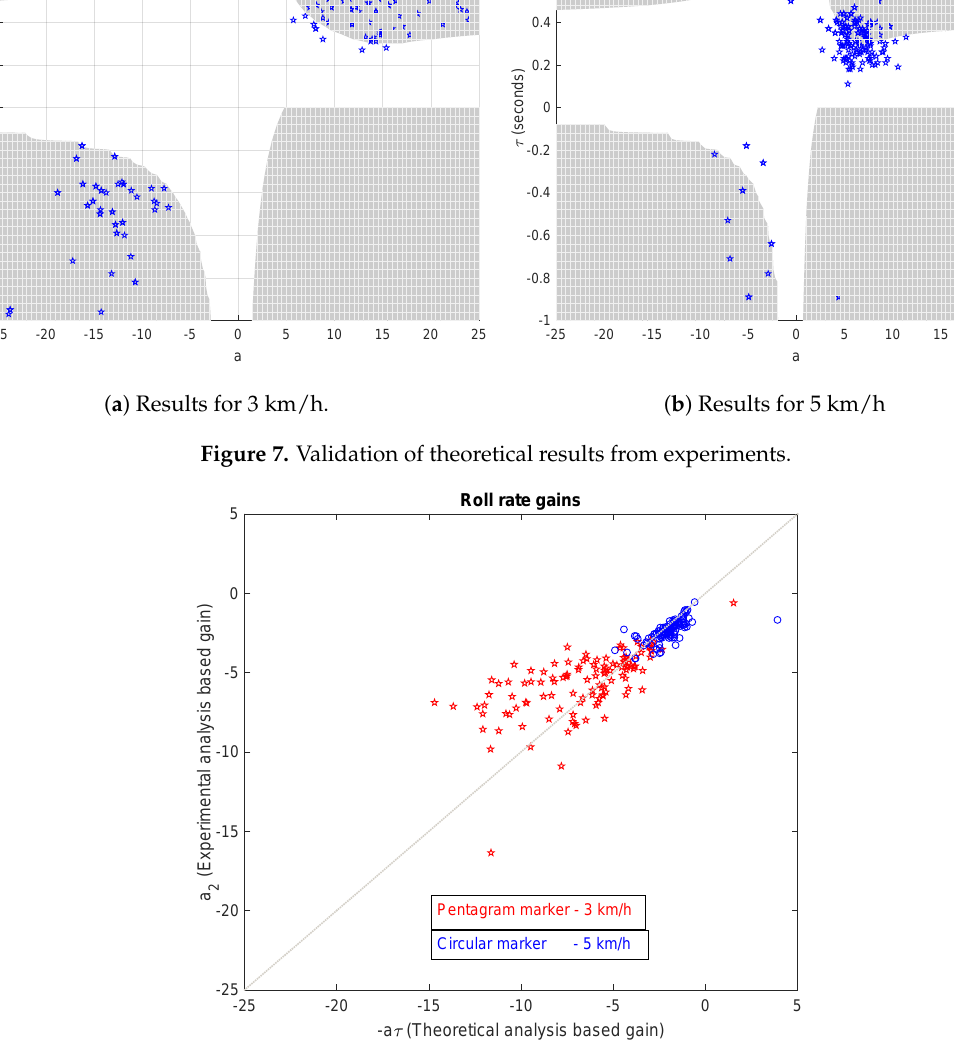
Figure 8. Validation of roll rate gain values based on theory and